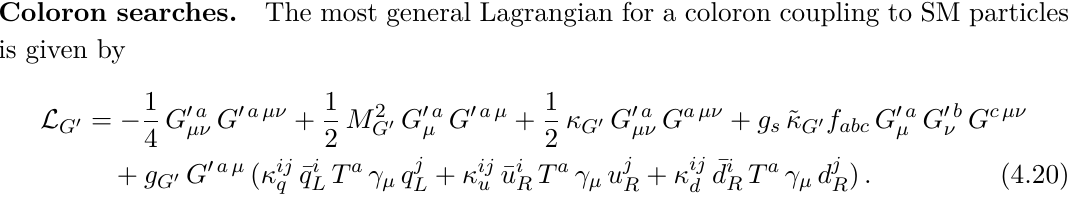
= − g ( M 0 ) 2 /g 2 (solid) and κ ii = 0 (dashed), and κ s q q G G 0 = 3 G 0